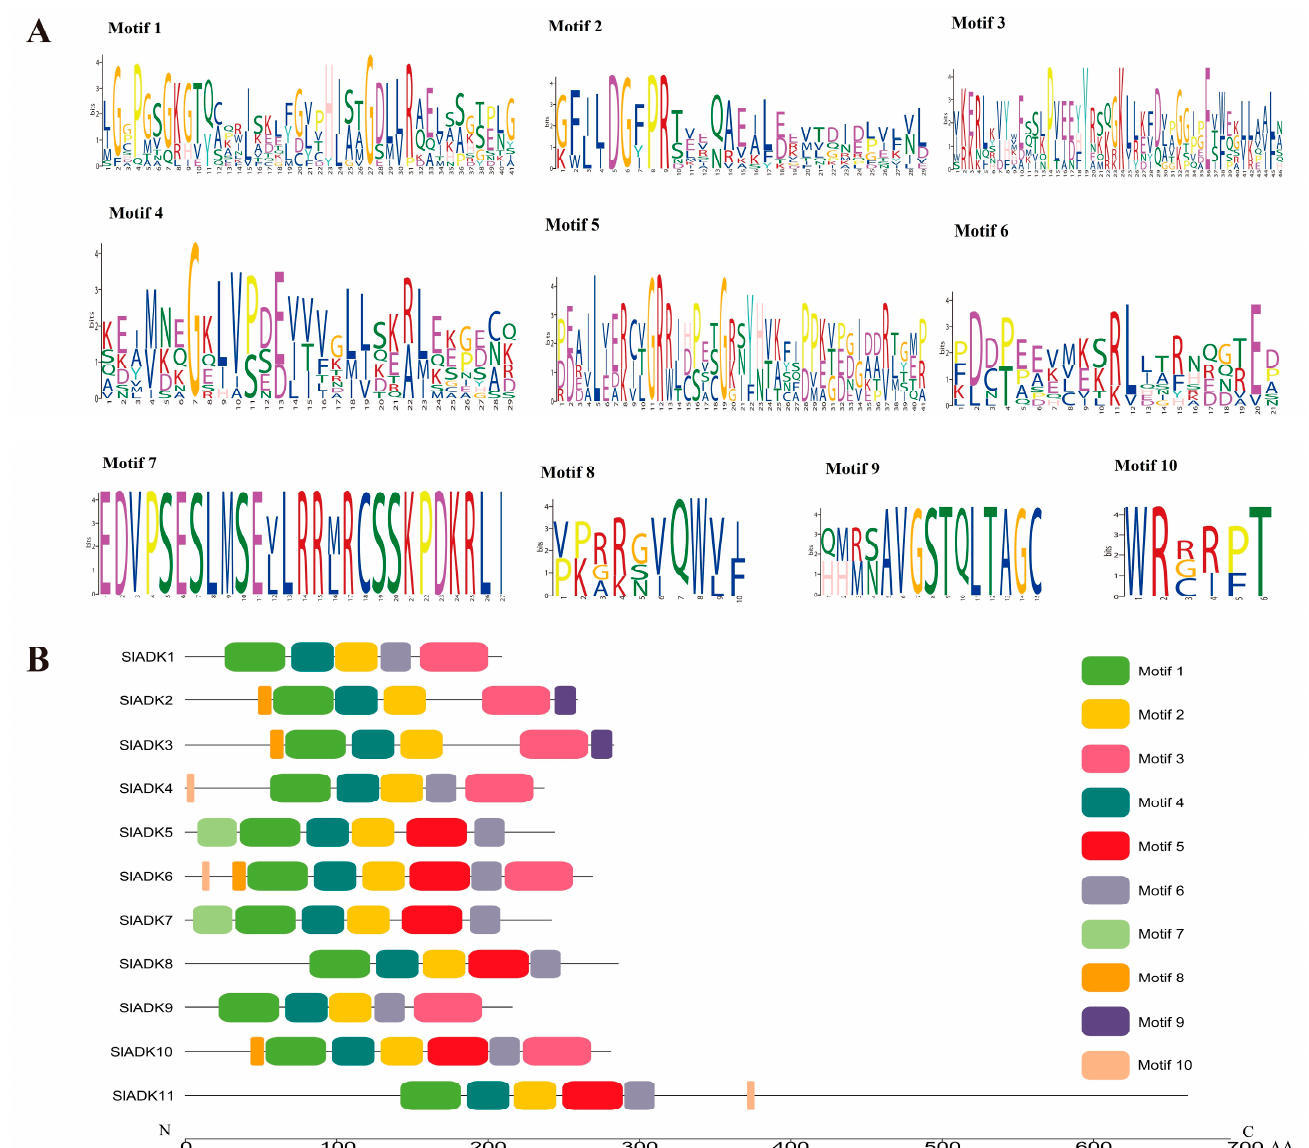
Figure 2. Details of ten conserved motifs and their distributions in SlADK proteins. ( A ) Details of ten selected motifs. Ten conserved motifs in SlADK proteins were generated by the online MEME tool. The overall height of the stack represents the level of sequence conservation. Heights of residues within a stack indicate the frequency of each residue at the indicated position. ( B ) The motif composition of tomato SlADK proteins. Ten putative motifs are indicated in different colored boxes. The length of each protein can be estimated using the scale at the bottom.